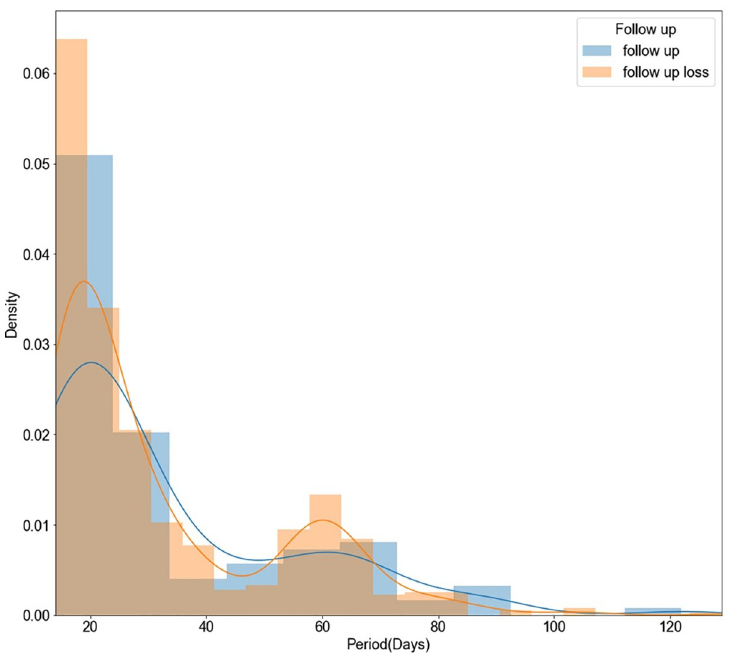
Fig 5. Density plot of length of